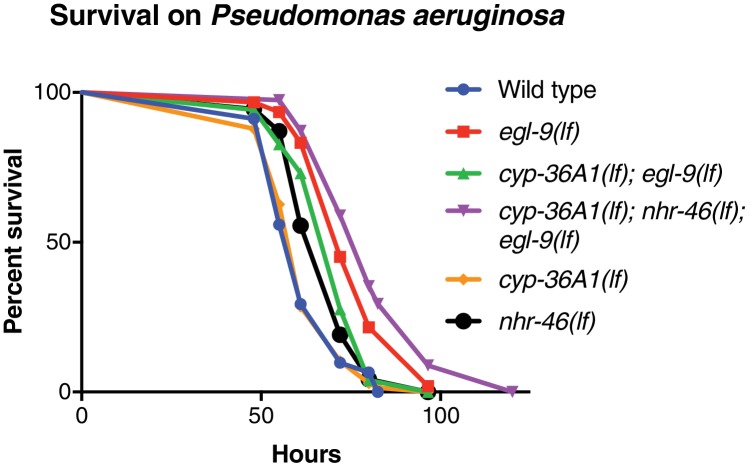
Replicate data for survival on Pseudomonas aeruginosa.Replicate data for Figure 4E. Wild type (n = 34) vs. egl-9(n586) (n = 61), p<0.001; egl-9(lf) vs. cyp-36A1(lf); egl-9(lf) (n = 52), p<0.05; cyp-36A1(lf); egl-9(lf) vs. cyp-36A1(lf); nhr-46(lf); egl-9(lf) (n = 39), p<0.001; wild type vs. cyp-36A1(lf) (n = 91), p>0.05; wild type vs. nhr-46(lf) (n = 54), p<0.05, as determined by the log-rank (Mantel-Cox) test, correcting for multiple comparisons with the Holm-Bonferroni method.